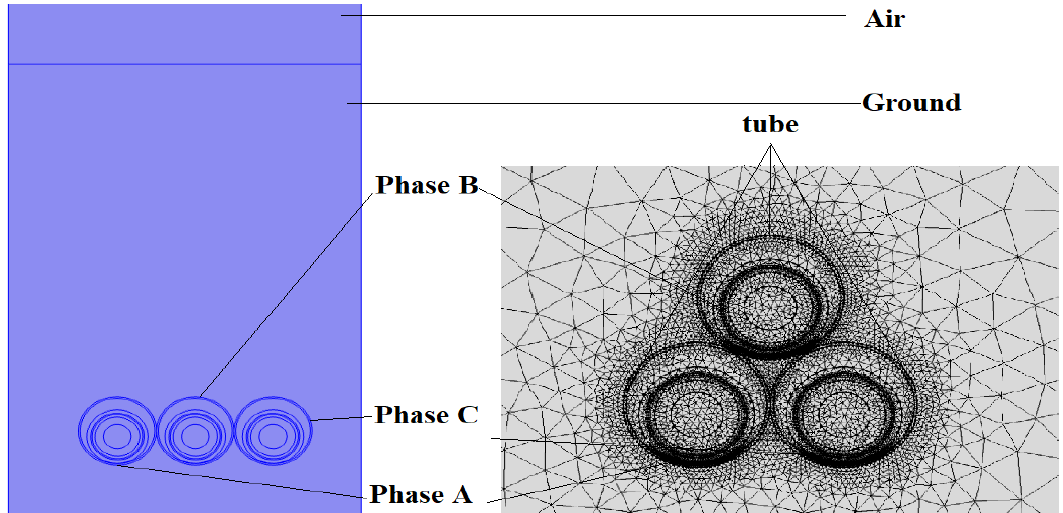
Figure 3. View of the model calculation range and a fragment of the applied mesh in the field of laying cable lines in the ground for two work systems in tube.